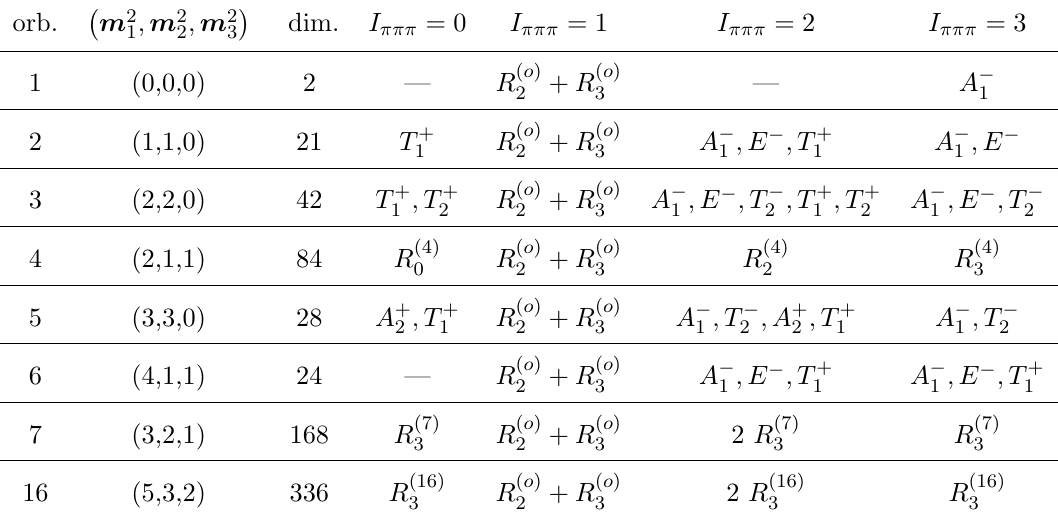
Table 5 . Cubic-group irreps for the three-pion operators with P = 0 and total charge zero for isospin I (cid:25)(cid:25)(cid:25) = 0, 2 and 3. These results include the intrinsic negative parity of the pions. The operators are those with the lowest seven noninteracting energies for a cubic box with mL together with the lowest-lying orbit having the maximal possible dimension. The (cid:12)rst column gives the orbit number, o , the second speci(cid:12)es the orbit, as described in the text, while the third gives the dimension of the orbit. The remaining columns list the irreps appearing in the orbit, R ( o ) . As indicated, results for I (cid:25)(cid:25)(cid:25) = 1 are given by summing the irreps in the I (cid:25)(cid:25)(cid:25) = 2 and I I (cid:25)(cid:25)(cid:25) = 3 columns. Entries in the I (cid:25)(cid:25)(cid:25) = 3 column agree with those in table 2 of ref.